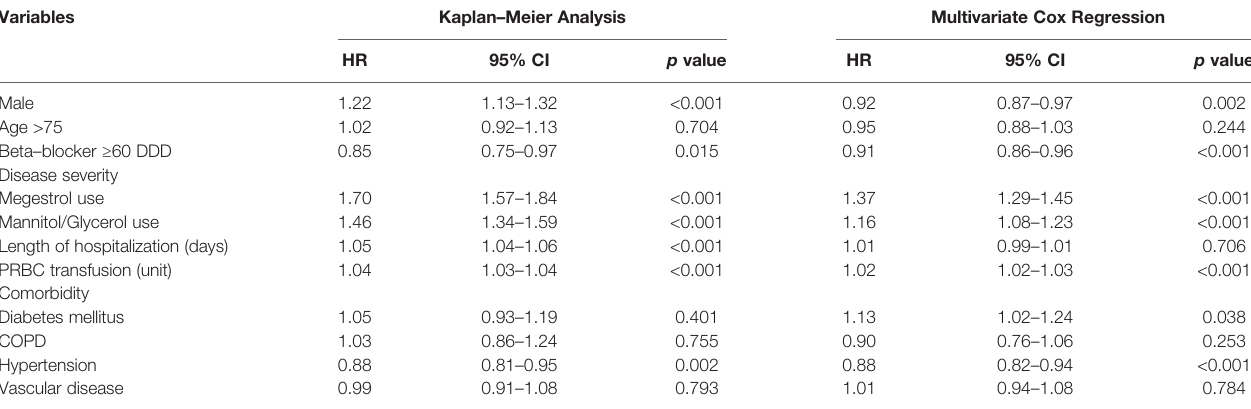
TABLE 2 | Multivariate Cox proportional hazards regression analysis for time to discontinuation of fi rst-line epidermal growth factor receptor tyrosine kinase inhibitors in 2 years. Variables Kaplan – Meier